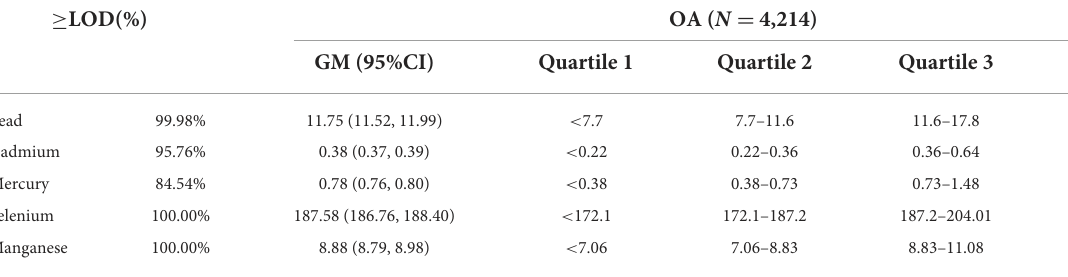
TABLE 2 Blood levels of heavy metals (ug/L) by osteoarthritis status in US aging people from NHANES 2011–2020.